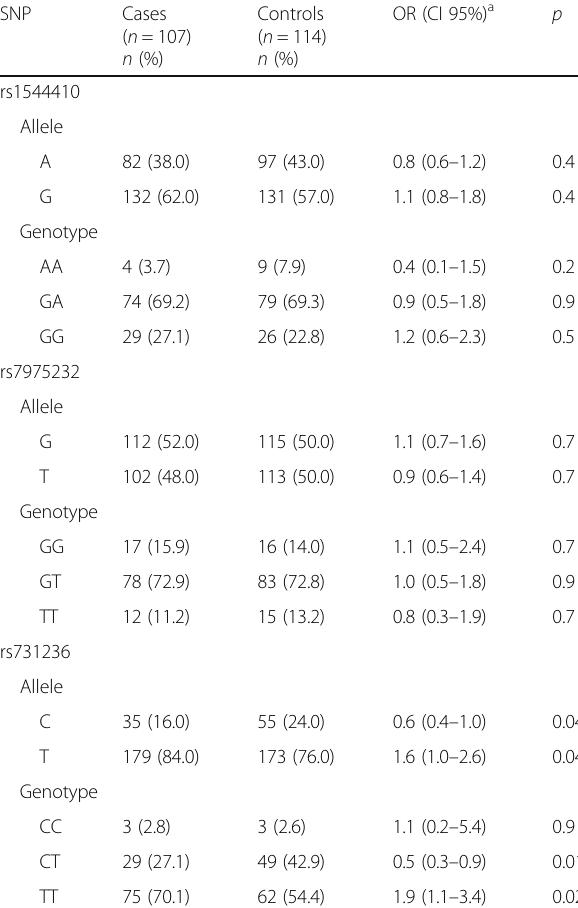
Table 3 Allelic and genotype association testing results of